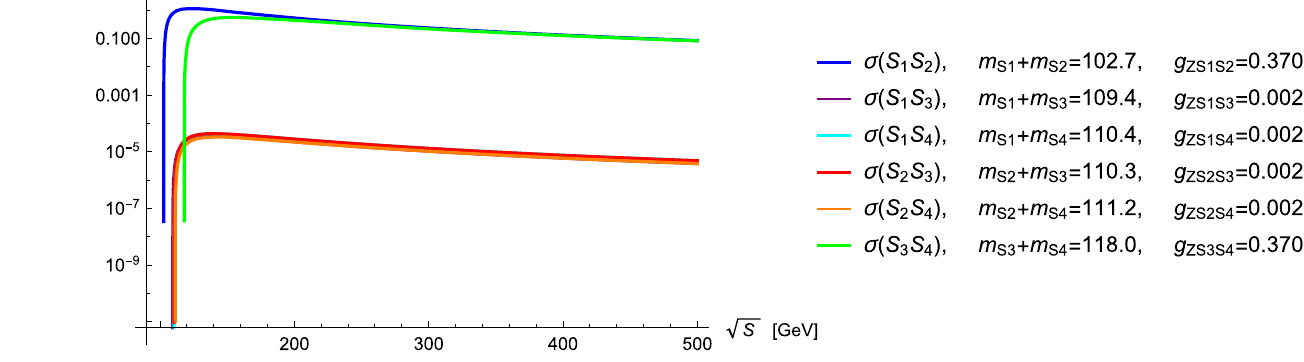
Points from the C type benchmark scenario, as shown in Fig. 4, have the specific characteristic of seeing all thresholds √ s values. The size of the various (nearly) overlapping at low cross sections is again dictated by the Z S i S j couplings and thus is largest for S 1 S 2 and S 3 S 4 over any of S 1 S 3 , S 1 S 4 , S 2 S 3 and S 2 S 4 , as previously seen